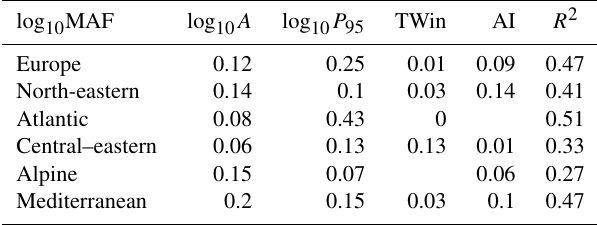
Table A3. Measure of general dominance (additional contributions) for MAF – indicating general dominance. For each row: the highest value indicates the most important variable in terms of improvement of the model fit for the given regression, the second highest indicates the second most important, and the lowest indicates the least important. Summing over measures gives R 2 of